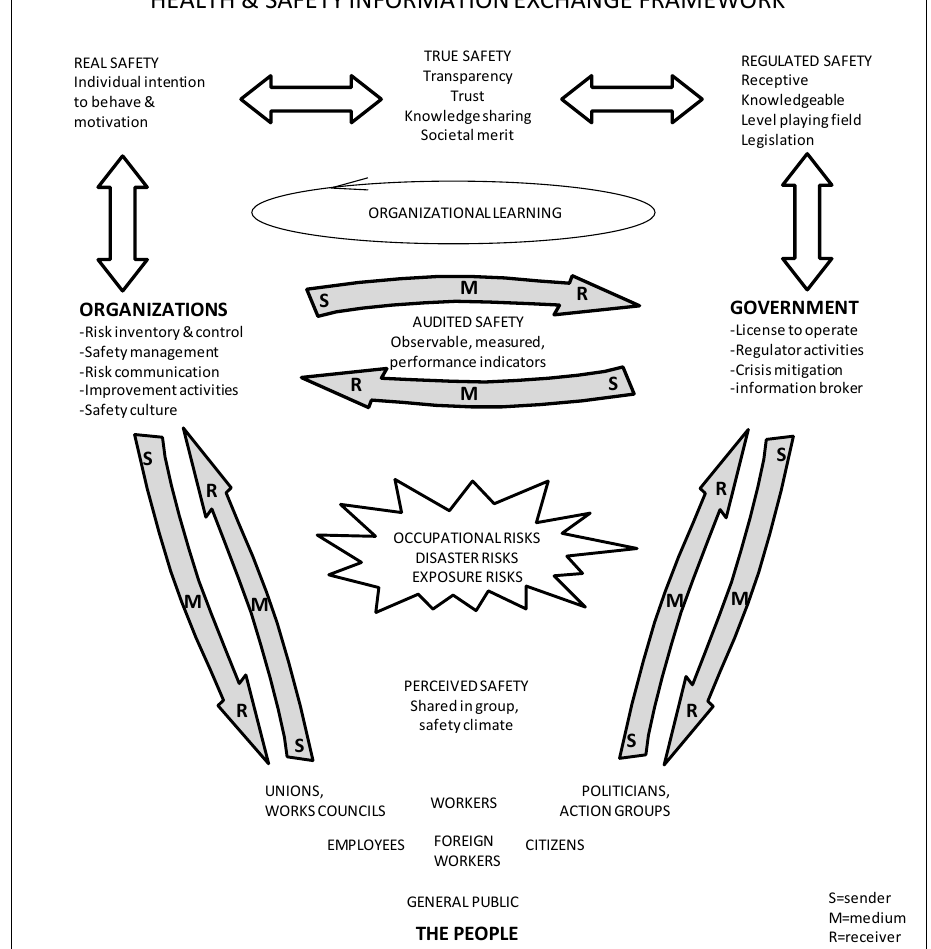
Figure 2. The “ transparency for safety ” triangle, a health and safety information exchange frame- Figure 2. The “transparency for safety” triangle, a health and safety information exchange framework, work, showing information flows between stakeholder groups. showing information flows between stakeholder